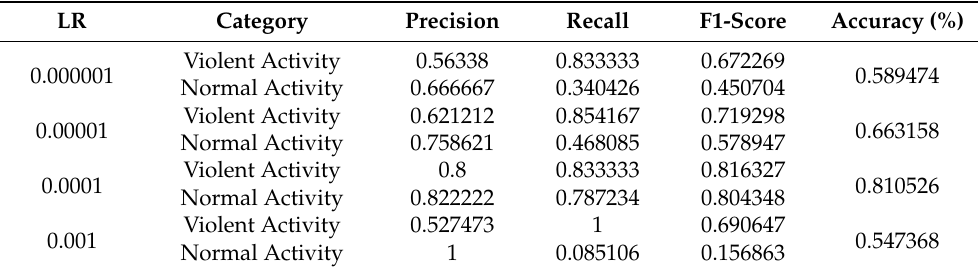
Table 12. Performance of lightweight LSTM model on Surveillance Fight dataset.